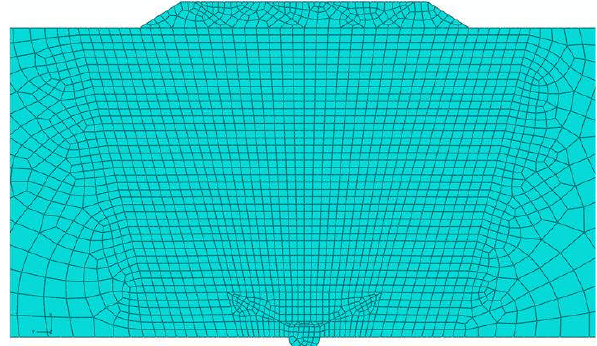
Figure 5. FE mesh showing the weld, HAZ and part of the pipe.